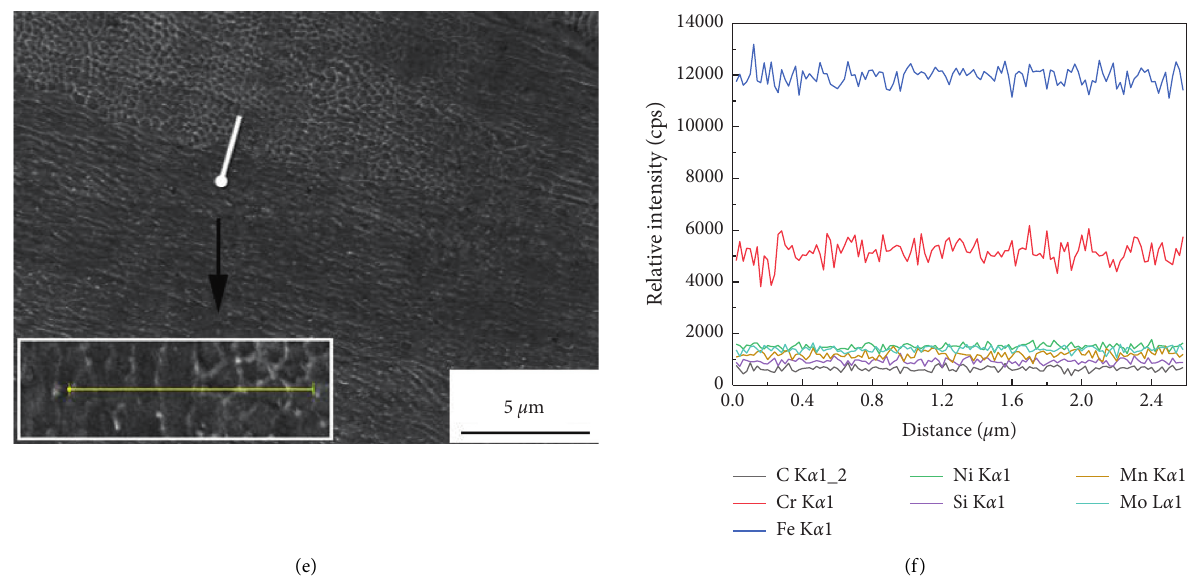
Figure 5: Microstructure and EDS analysis of the deposited SLM 316L stainless steel samples. (a) Transverse section of a cellular structure, (b) longitudinal section of a cellular structure, (c) three-dimensional view of cellular structure, (d) growth direction of cellular crystal between adjacent molten pool boundaries, (e) scope of the EDS line scan, and (f) elemental analysis of the EDS line